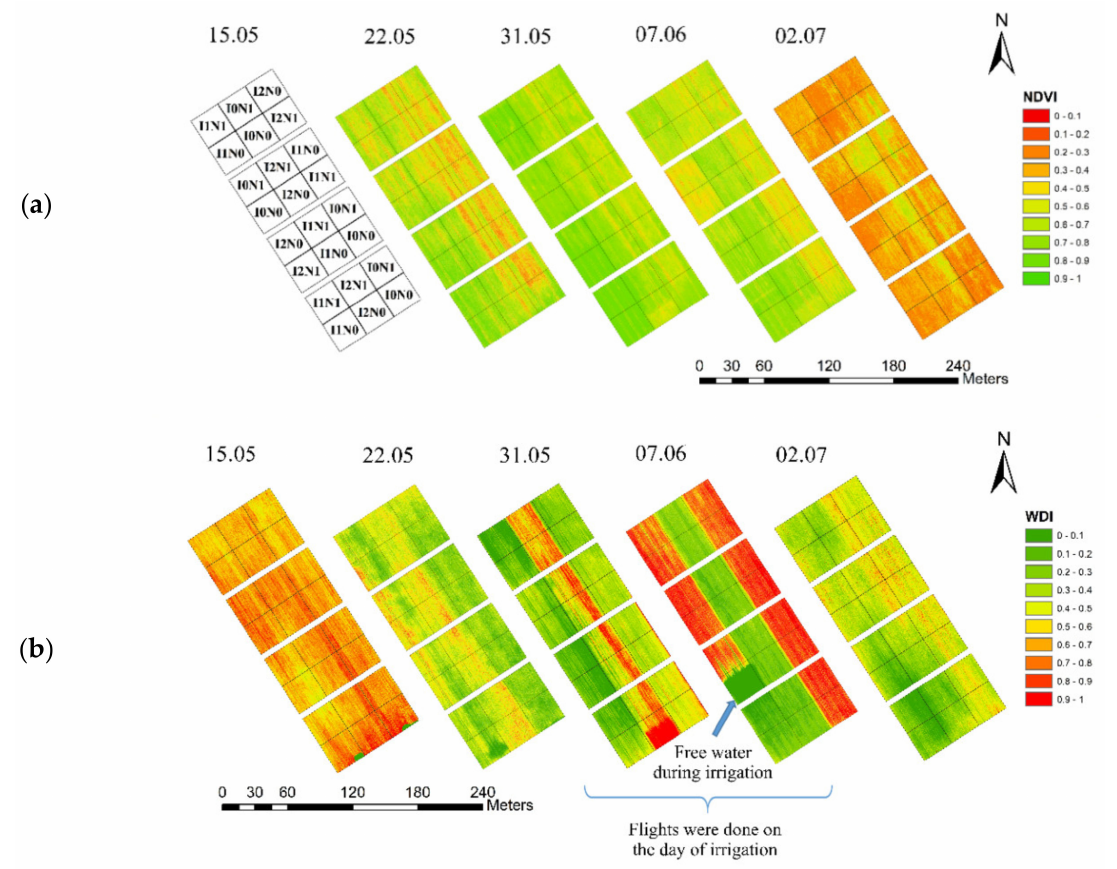
Figure 2. Spatiotemporal distribution of the Normalized Difference Vegetation Index ( NDVI ; ( a )) and Water Deficit Index ( WDI ; ( b )) for the winter wheat season in 2018 in Denmark. I0; I1 and I2 denote minimum, optimum and full irrigation, respectively. and N0 and N1 are basic and full treatments (see Table A2 in the Appendix A for irrigation time and